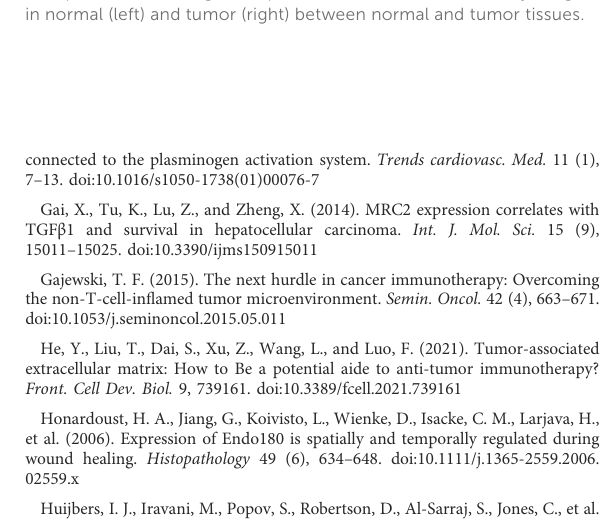
SUPPLEMENTARY FIGURE S5 The correlation of MRC2 expression with immune in fi ltration level in ACC, DLBC,LAML,TGCT,andUVM.Thecorrelation fi lterwassetas p < 0.001and |R| > 0.5. SUPPLEMENTARY FIGURE S6 ExpressioncorrelationbetweenMRC2expressionandimmuneinhibitors. The top four immune inhibitors with the correlation coef fi cient of MRC2 expression level were displayed via dot plots. SUPPLEMENTARY FIGURE S7 Expression correlation between MRC2 expression and immune stimulators. The top four immune stimulators with the correlation coef fi cient of MRC2 expression level were displayed via dot plots. SUPPLEMENTARY FIGURE S8 Expression correlation between MRC2 expression and MHC molecules. The top four MHC molecules with the correlation coef fi cient of MRC2 expression level were displayed via dot plots. SUPPLEMENTARY FIGURE S9 KEGG enrichment analysis of MRC2 in BLCA (A) , KIRC (B) , LGG (C) , and UVM (D) . SUPPLEMENTARY FIGURE S10 Comparison of MRC2 gene expression immunohistochemistry images in normal (left) and tumor (right) between normal and tumor